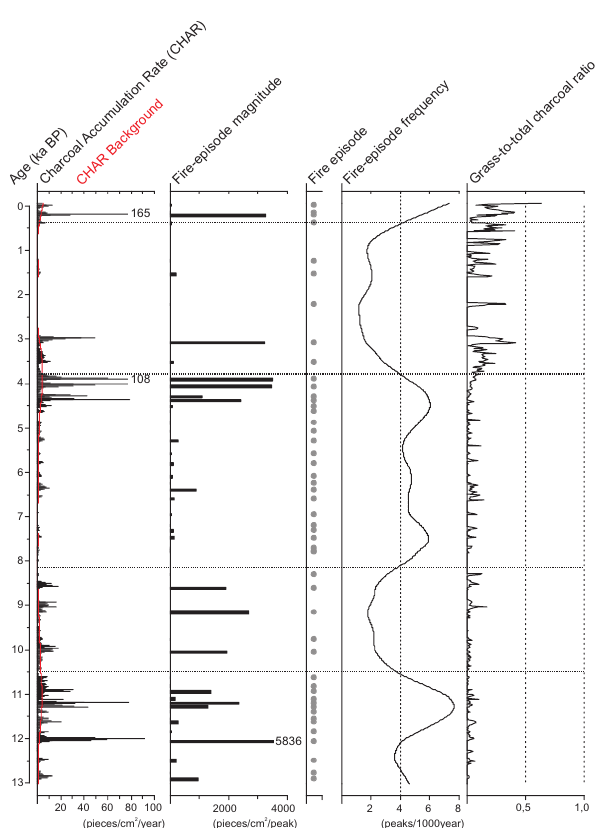
Figure 5. Charcoal record from Mallín El Embudo including charcoal accumulation rate (CHAR), fire-episode magnitude, fire episodes, fire-episode frequency and grass-to-total-charcoal ratio. The horizontal lines show the division of the record according to fire regime